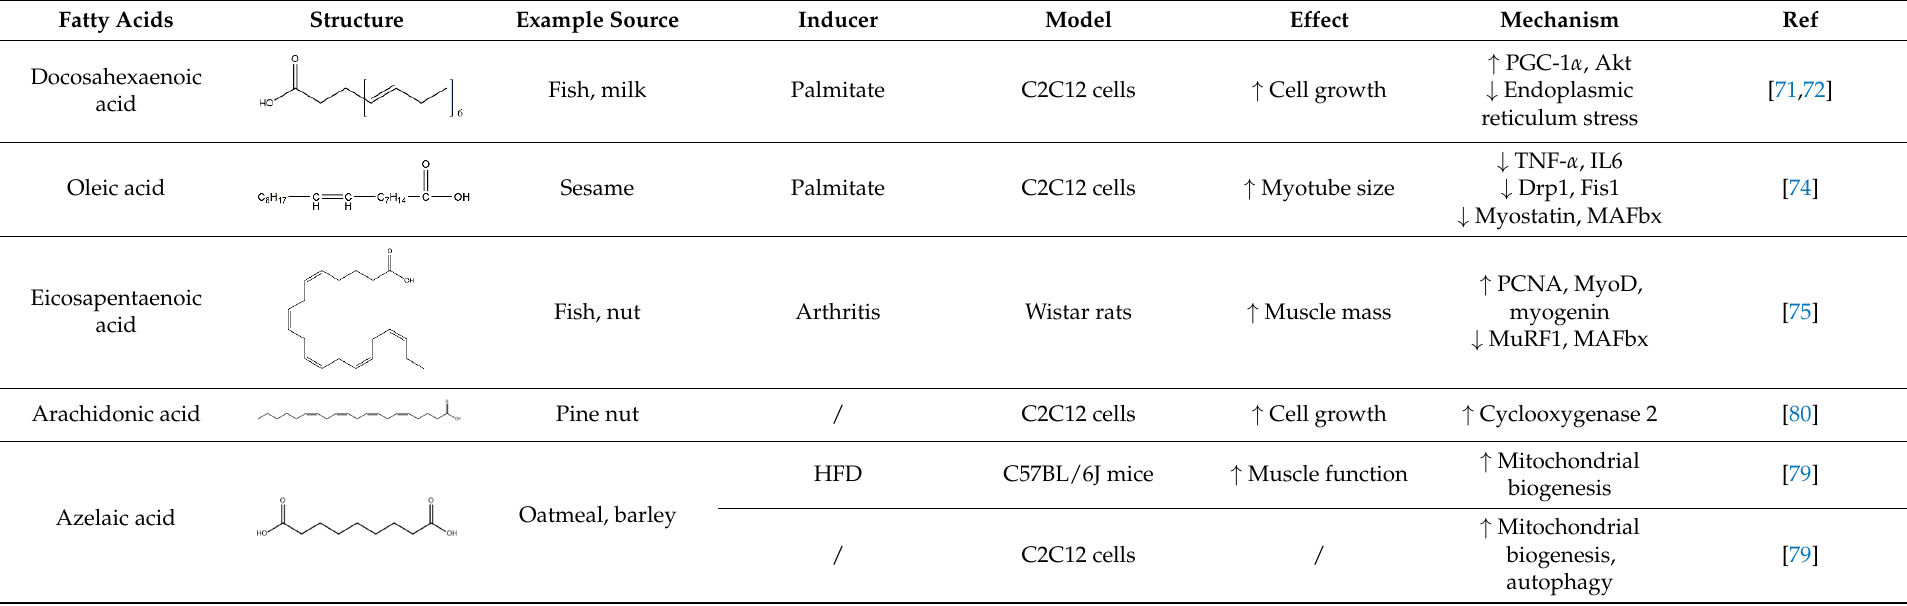
Table 4. Fatty acids in the prevention of the muscle atrophy in vitro/vivo.